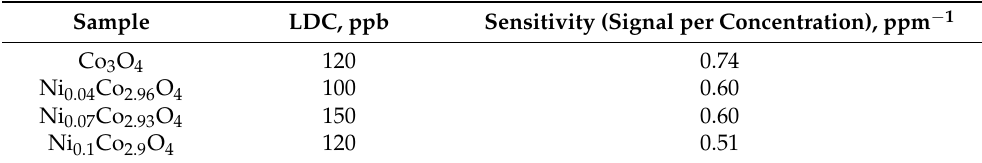
Table 2. Lowest detectable concentration (LDC) of H 2 S for sensors based on Co 3 O 4 and Ni x Co 3 − x O 4 materials measured at 210 °C.